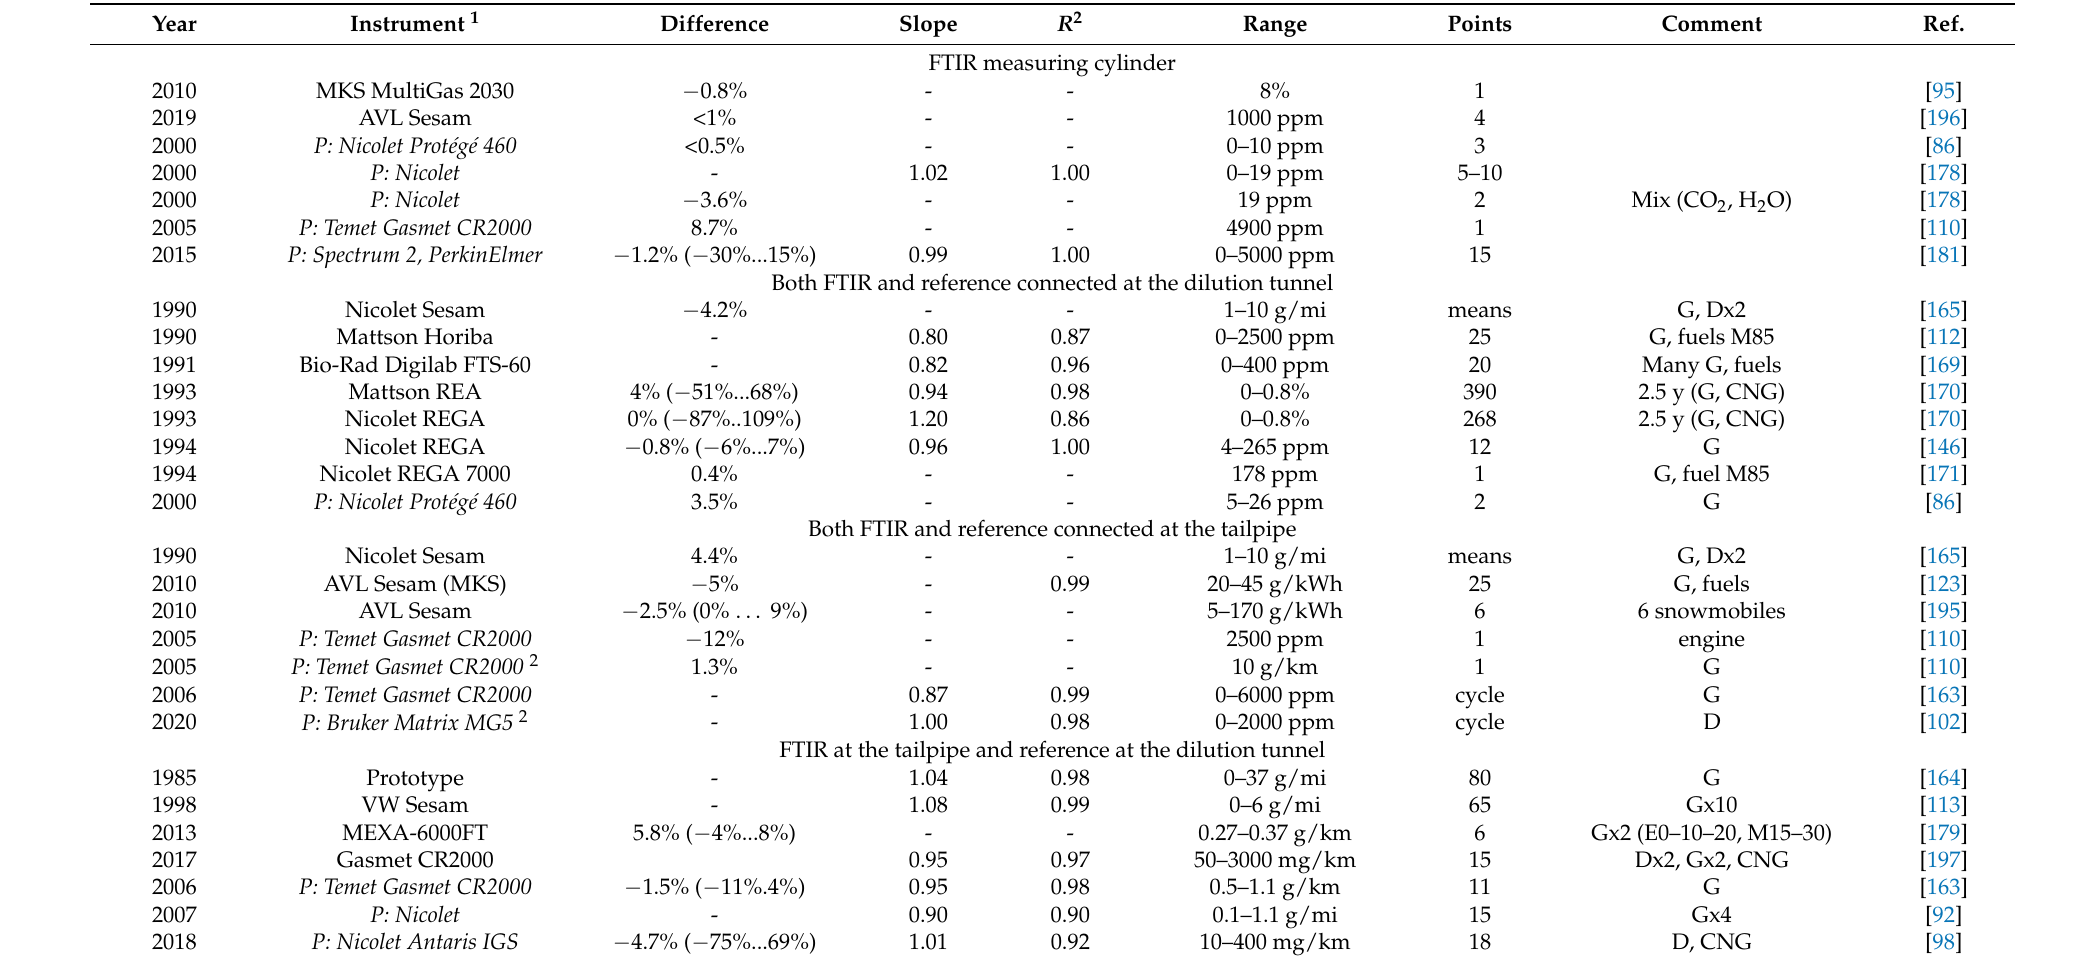
Table A2. Comparisons of FTIR with CO analyzers (all